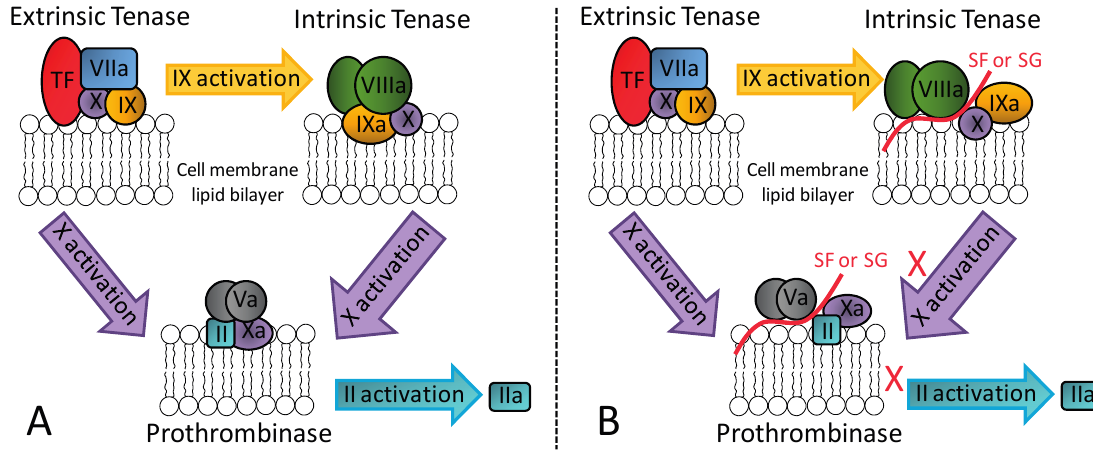
Figure 3. ( A ) Representation of the three key coagulation complexes: extrinsic tenase, intrinsic tenase and prothrombinase. ( B ) The serpin-independent anticoagulant mechanism of marine non-GAG sulfated glycans (SF or SG) relies on the assembly inhibition of the intrinsic tenase and protrombinase